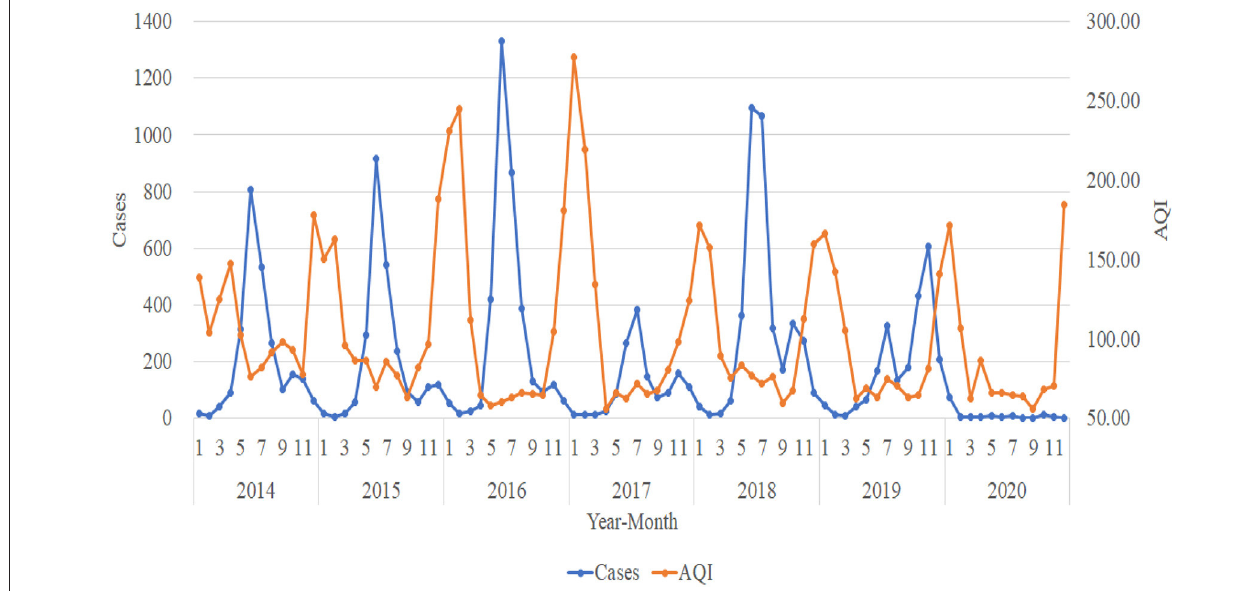
FIGURE 4 | Trends in the number of HFMD cases and AQI.